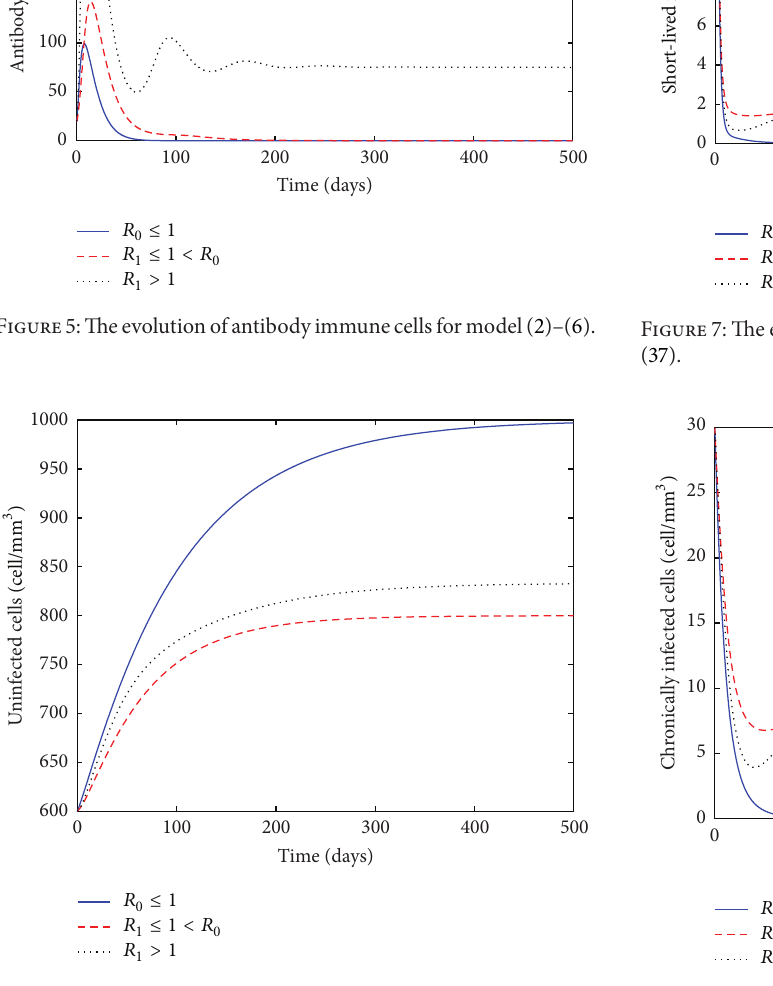
Figure 8: The evolution of chronically infected cells for model (33)–